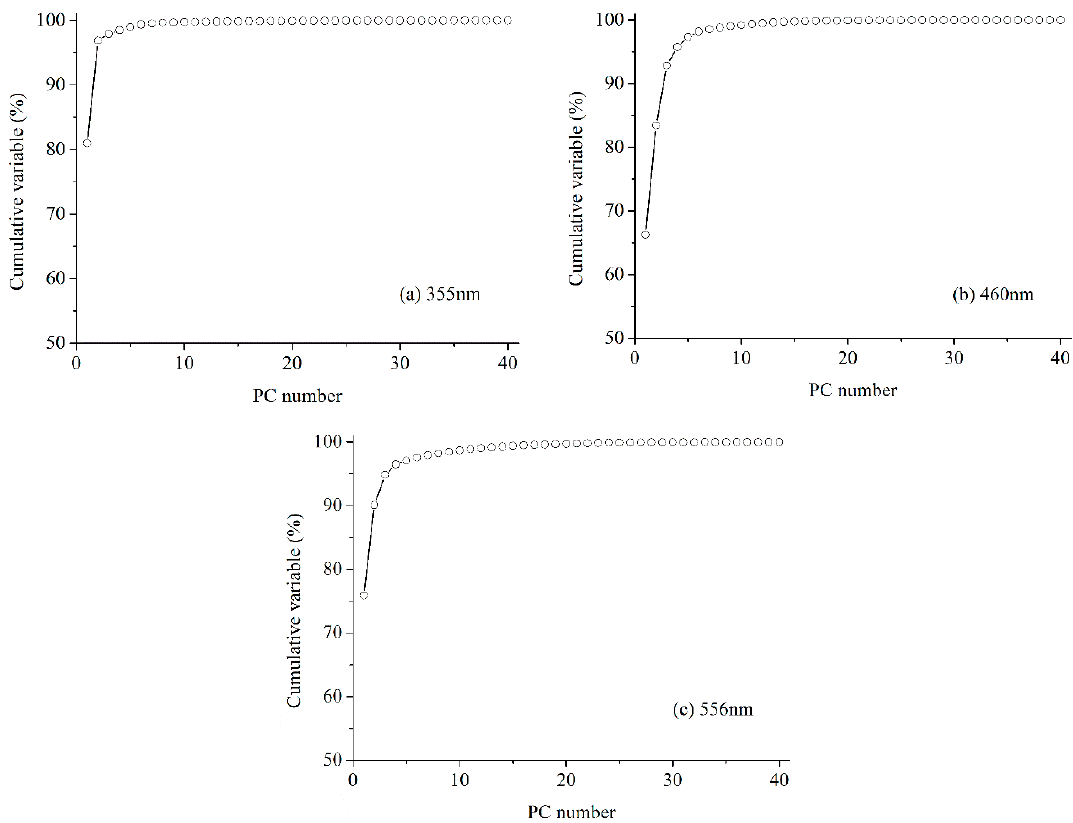
Figure 7. Cumulative explained variances of PC for different excitation light wavelengths. ( a ) 355 nm, ( b ) 460 nm, ( c ) 556 nm.